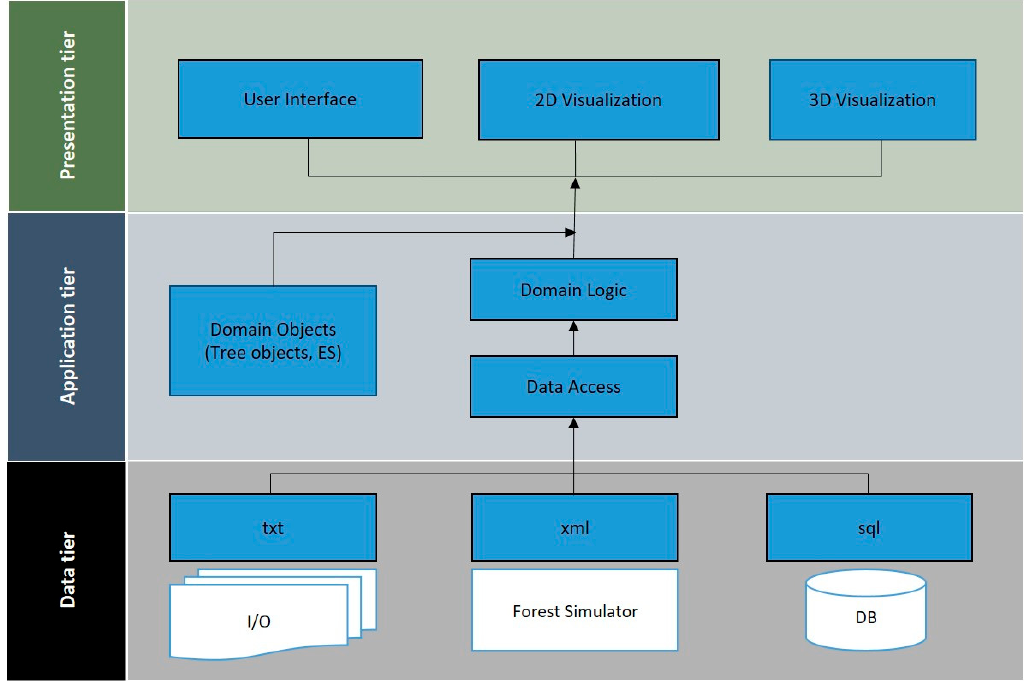
Figure 2. System architecture: three-tier design consisting of a data tier, presentation tier, and application tier. Data from di ff erent sources are processed in the application layer and sent to the presentation